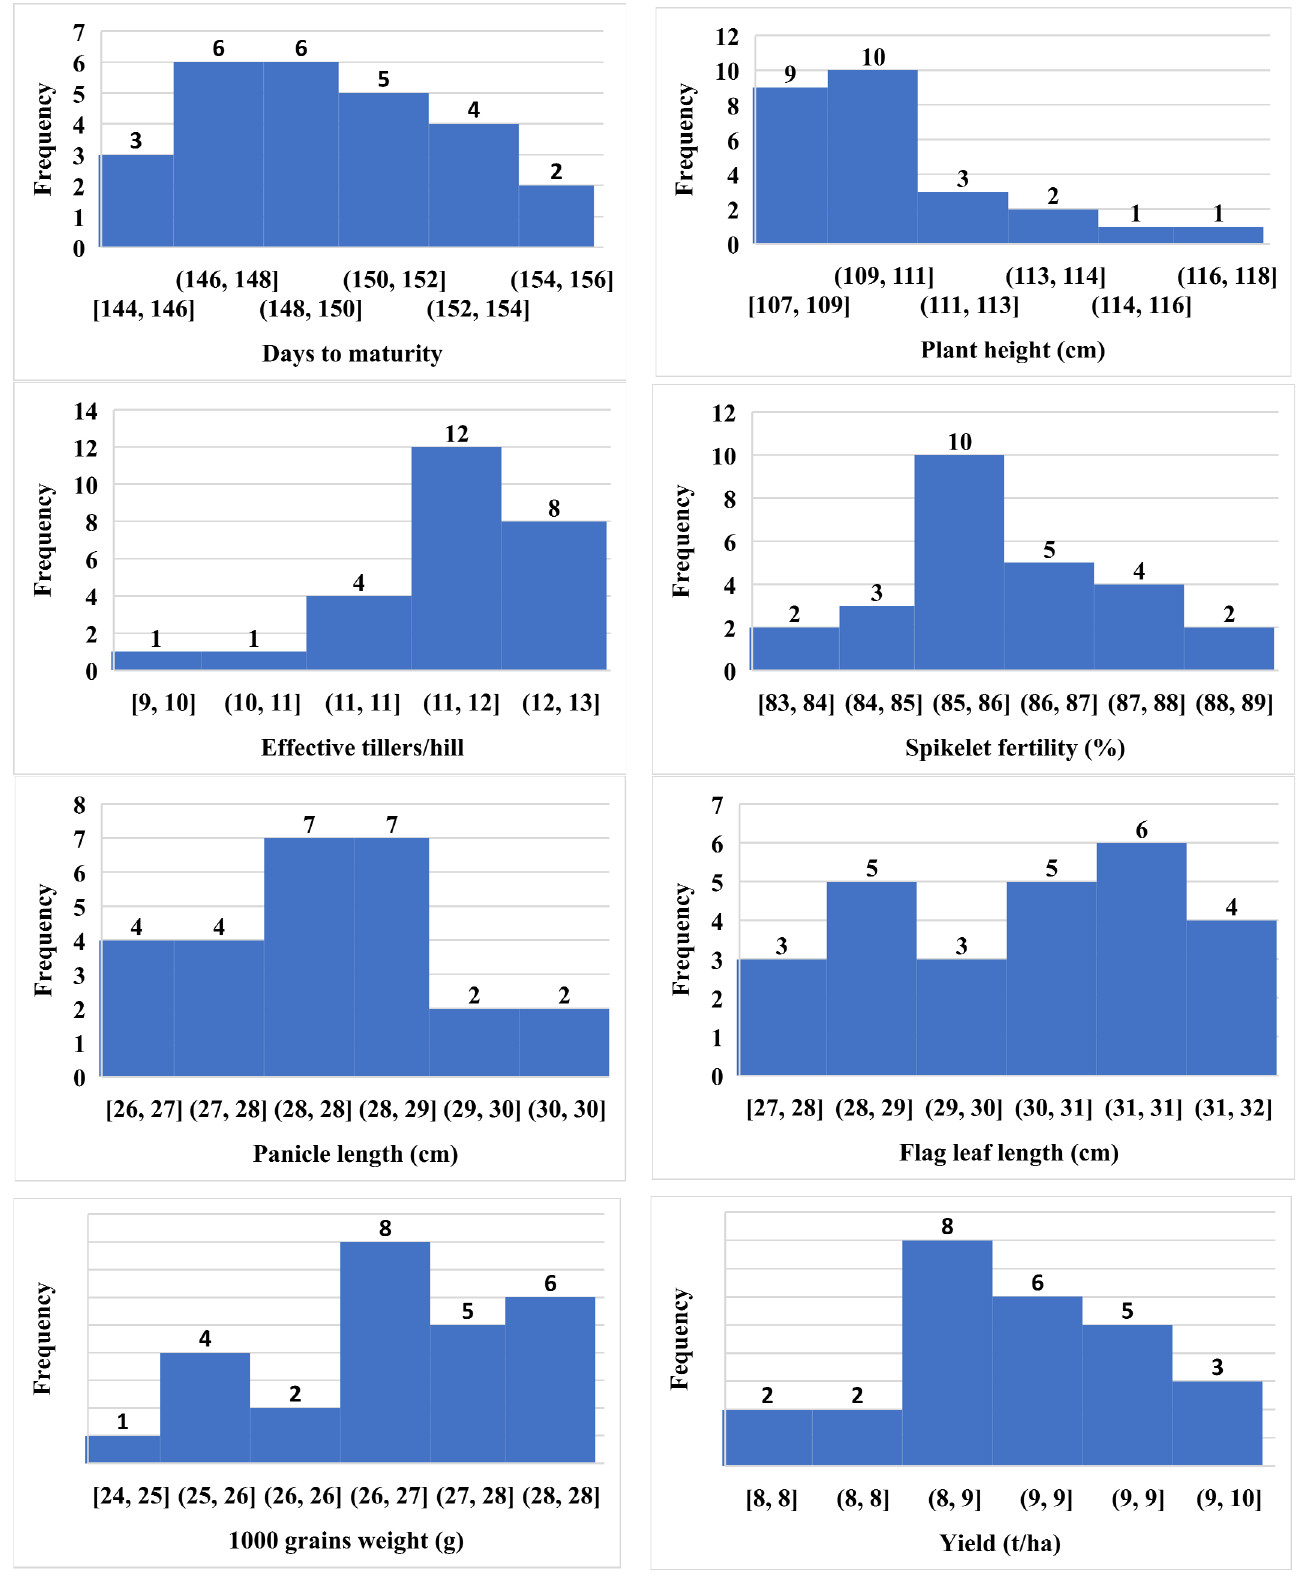
Figure 2. Histogram showing the frequency distribution of 26 hybrid combinations.